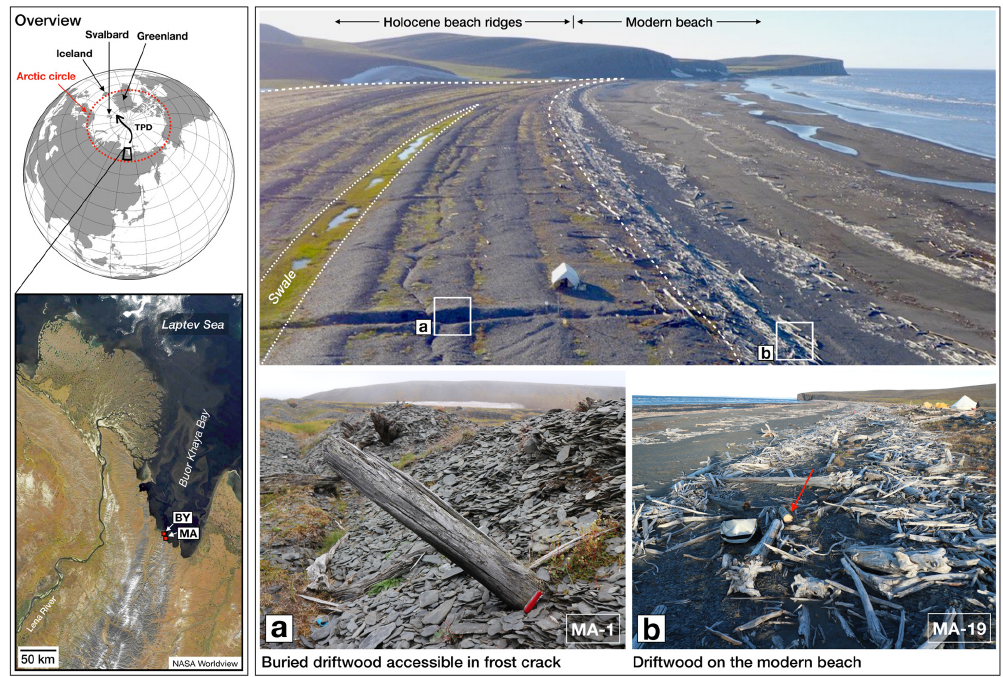
Figure 1. Left: overview sketch of the location of the research area. Top right: aerial view of the Makhchar field site showing the location of the Holocene beach ridges and the modern beach, with the distribution of wood arranged in drift lines from high-, medium-, and low-energy situations. Bottom right: (a) buried Holocene driftwood accessible in a frost crack and (b) a dense assemblage of driftwood on the modern beach face (code indicates sample ID; see Table